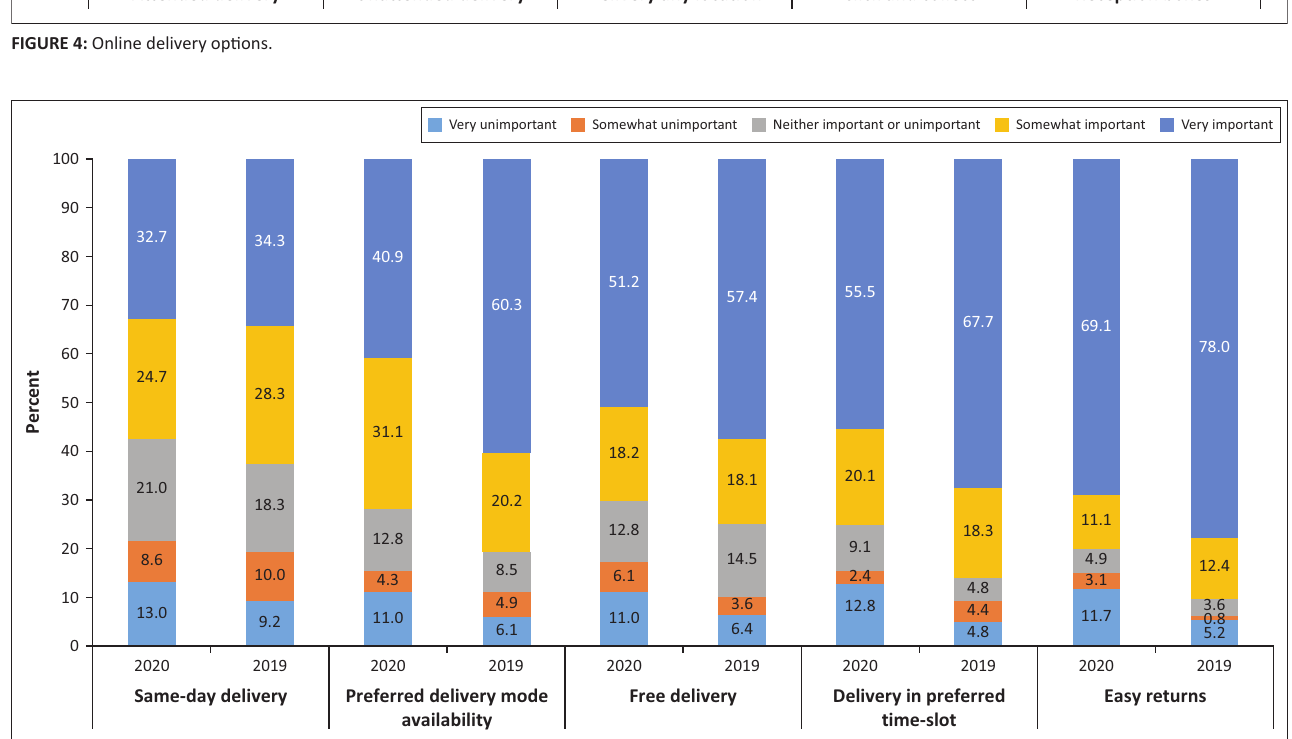
FIGURE 5: Important factors influencing online shopping decisions.